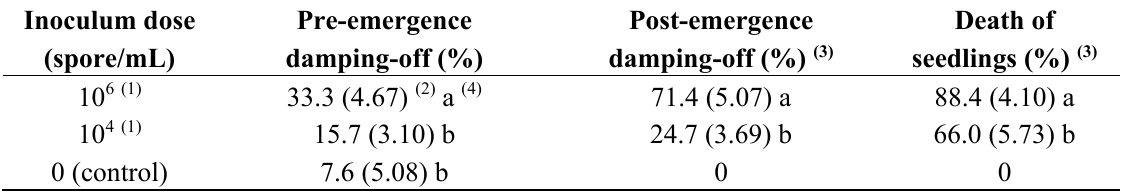
Table 4. Effect of inoculum doses on percentage of pre- and post-emergence damping off, and death of established seedlings caused by F. circinatum on externally inoculated seeds of P. radiata